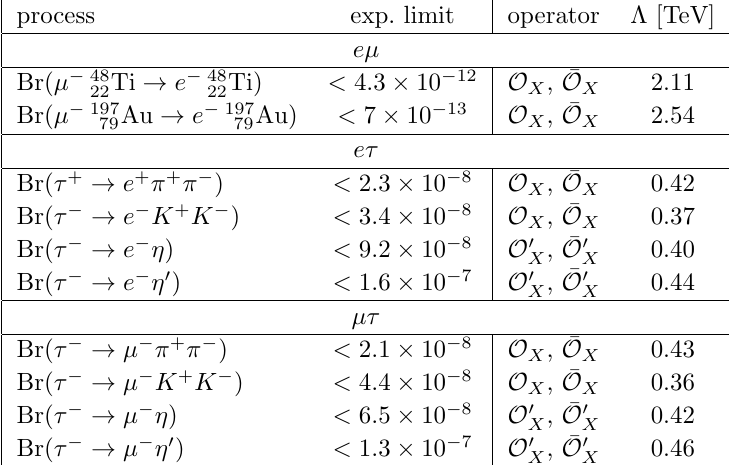
Table 2 . Relevant assumptions for (cid:22) - e conversion in nuclei. S ( p ) and S ( n ) denote the overlap integrals [50] and (cid:0) capt the capture rate of (cid:22) (cid:0) in the nucleus [50, 51]. process